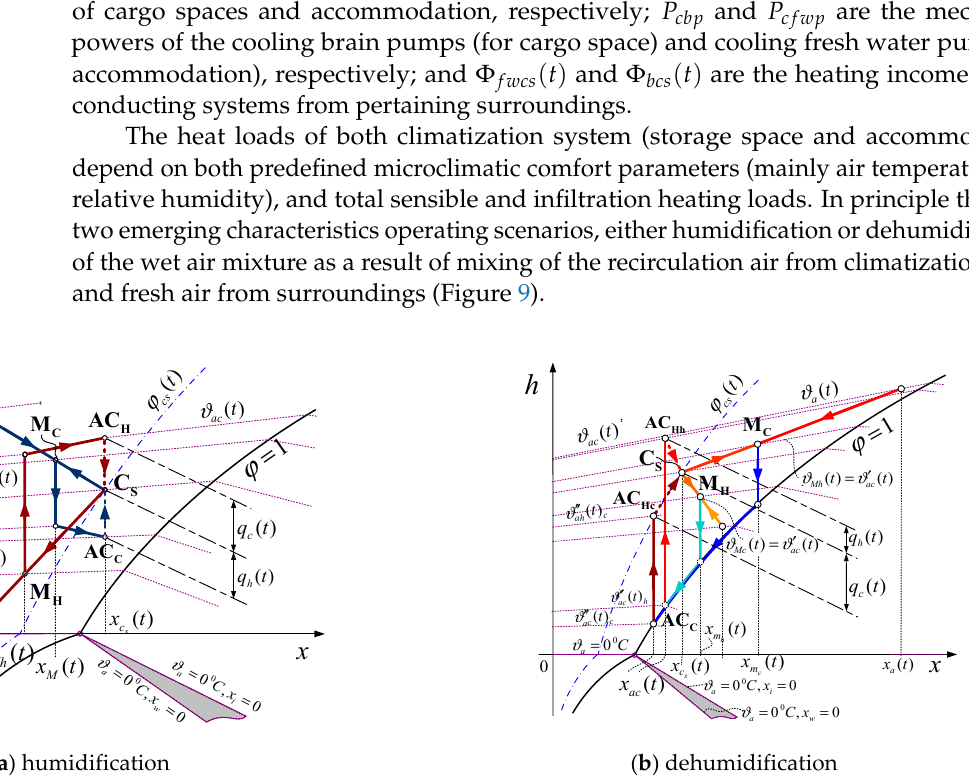
Figure 9. The air conditioning processes for the ship’s spaces in a Mollier h - x